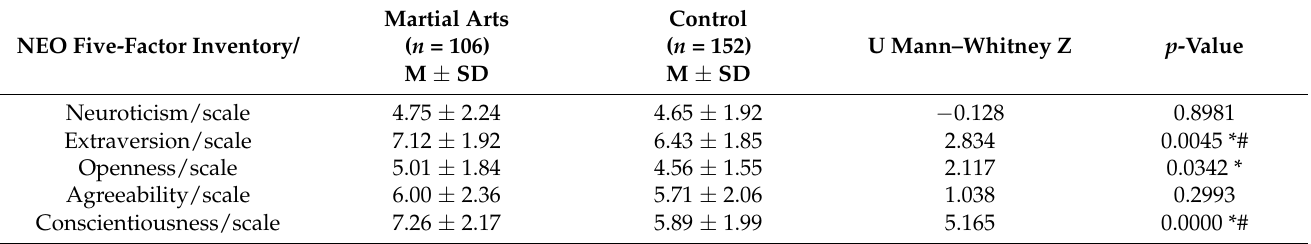
Table 2. Analysis of NEO Five-Factor Inventory results in martial arts subjects and